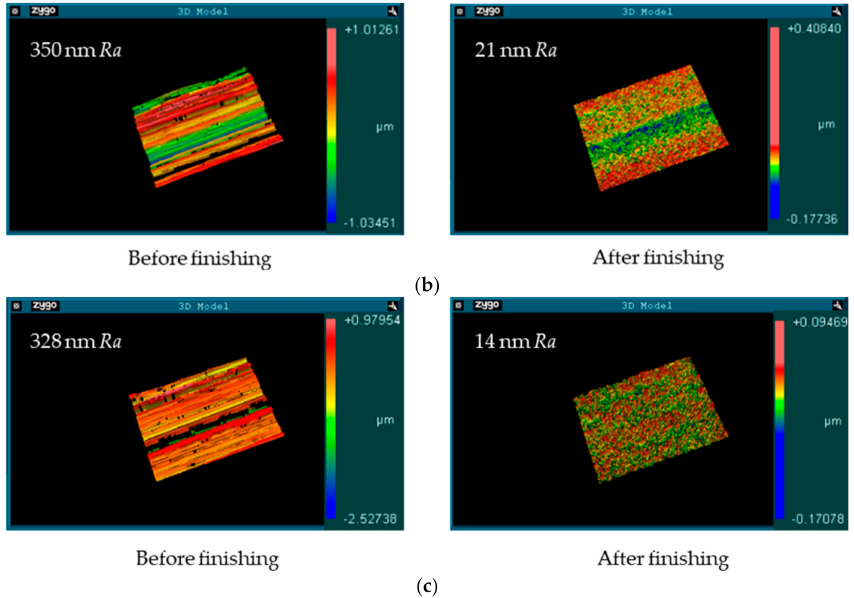
Figure 17. 3D photographs of the workpiece surface before and after finishing. ( a ) 350 rpm; ( b ) 450 rpm; ( c ) 550